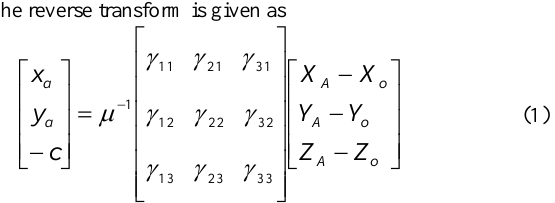
Figure 2. Scheme of the reference image and search